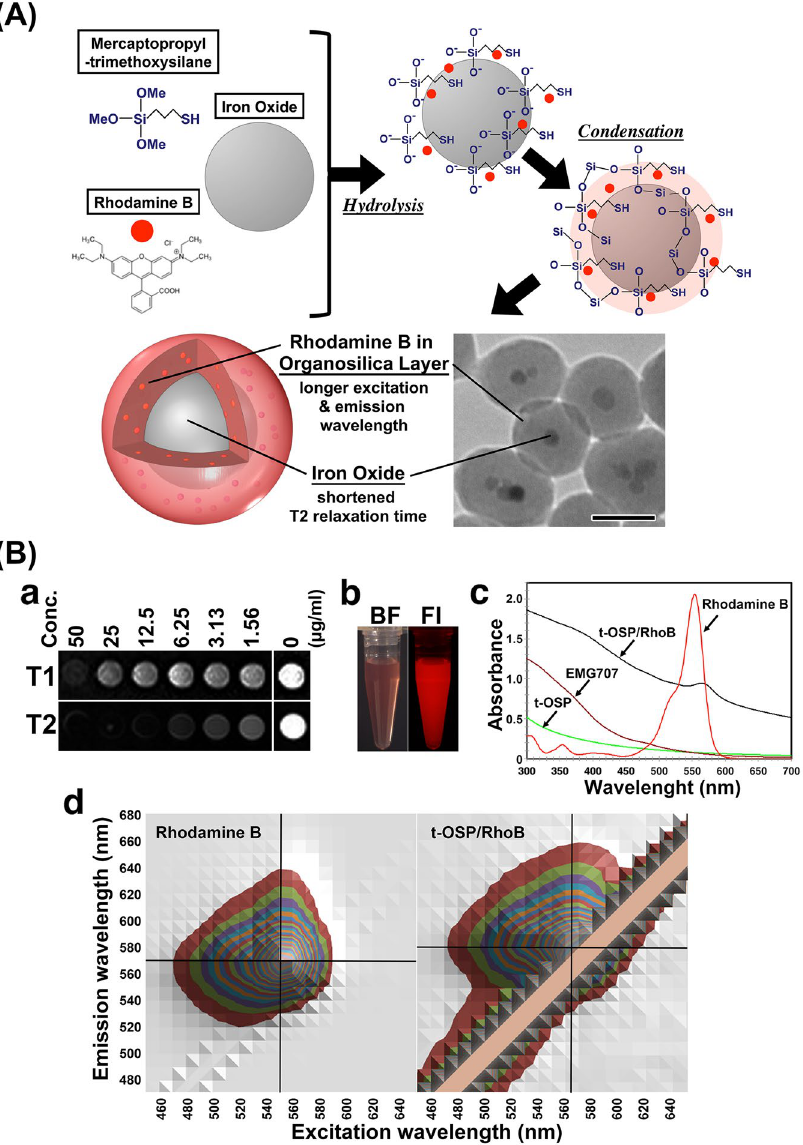
Figure 1. Preparation and characterization of thiol-OS-MNP/Rho. ( A ) Scheme of the formation and electron microscopic finding of thiol-OS-MNP/Rho. ( B ) Panel a shows the T1 and T2 weighted images that were obtained with spin echo and turbo spin echo seaquence, respectively. Acquisition patameters were as belows; (T1 weighted image) TR = 300 ms, TE = 10 ms, 3 mm thickness, FOV = 240 × 144 mm 2 , matrix = 256 × 108, NEX = 8, (T2 weighted image) TR = 5000 ms, TE = 89 ms, 3 mm thickness, FOV = 240 × 142 mm 2 , matrix = 448 × 160, NEX = 4. Panel b showed findings of bright field imaging (BF) and fluorescent imaging (FI). (c) Absorbance spectra of t-OSP/RhoB, rhodamine B, EMG707, and thiol organosilica particles without rhodamine B nor EMG707. (d) Comprehensive 3-dimentional analysis of the excitation, emission, and fluorescence intensities for rhodamine B and